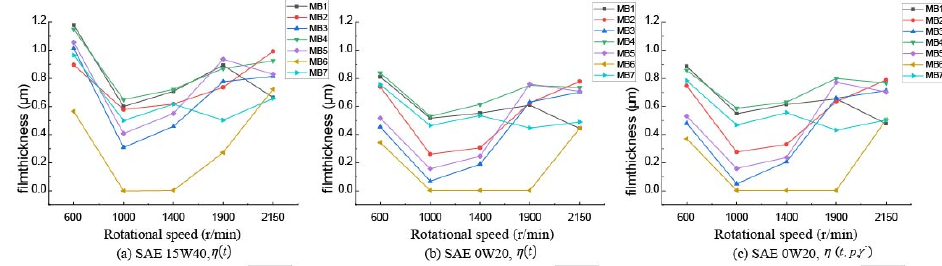
Figure 12. Minimum oil film thickness of each main bearing under typical working conditions.